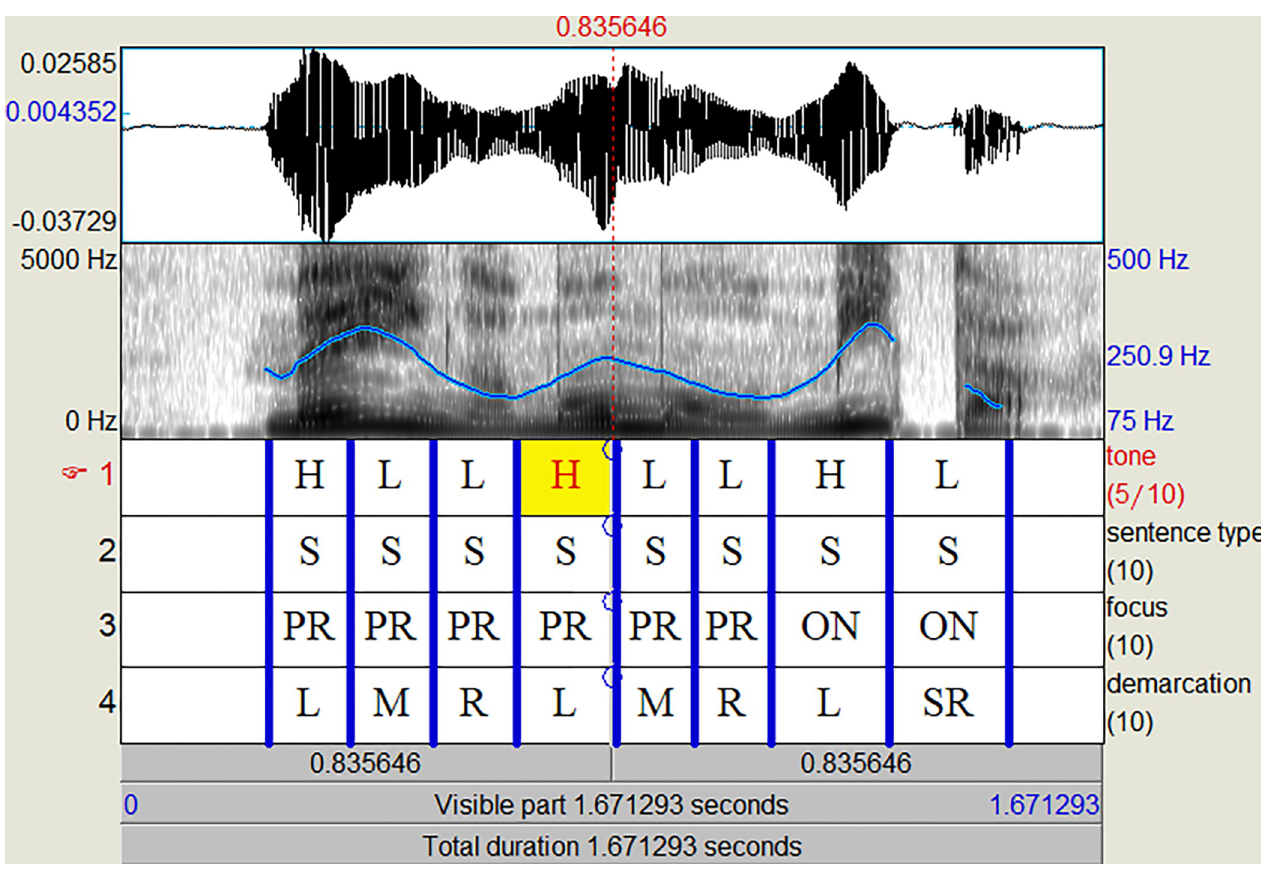
Fig 2. Example of functional labelling using